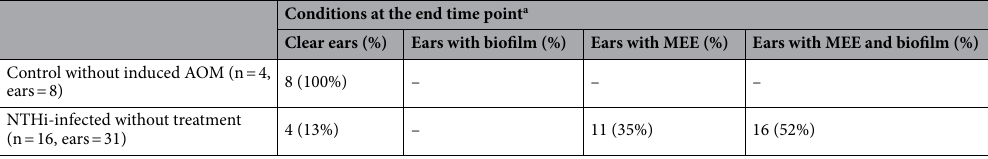
Table 1. Summary of longitudinal tracking of experimental OM in chinchilla. a The ears with a complete blockage of the ear canal at the end time point were excluded for this analysis.